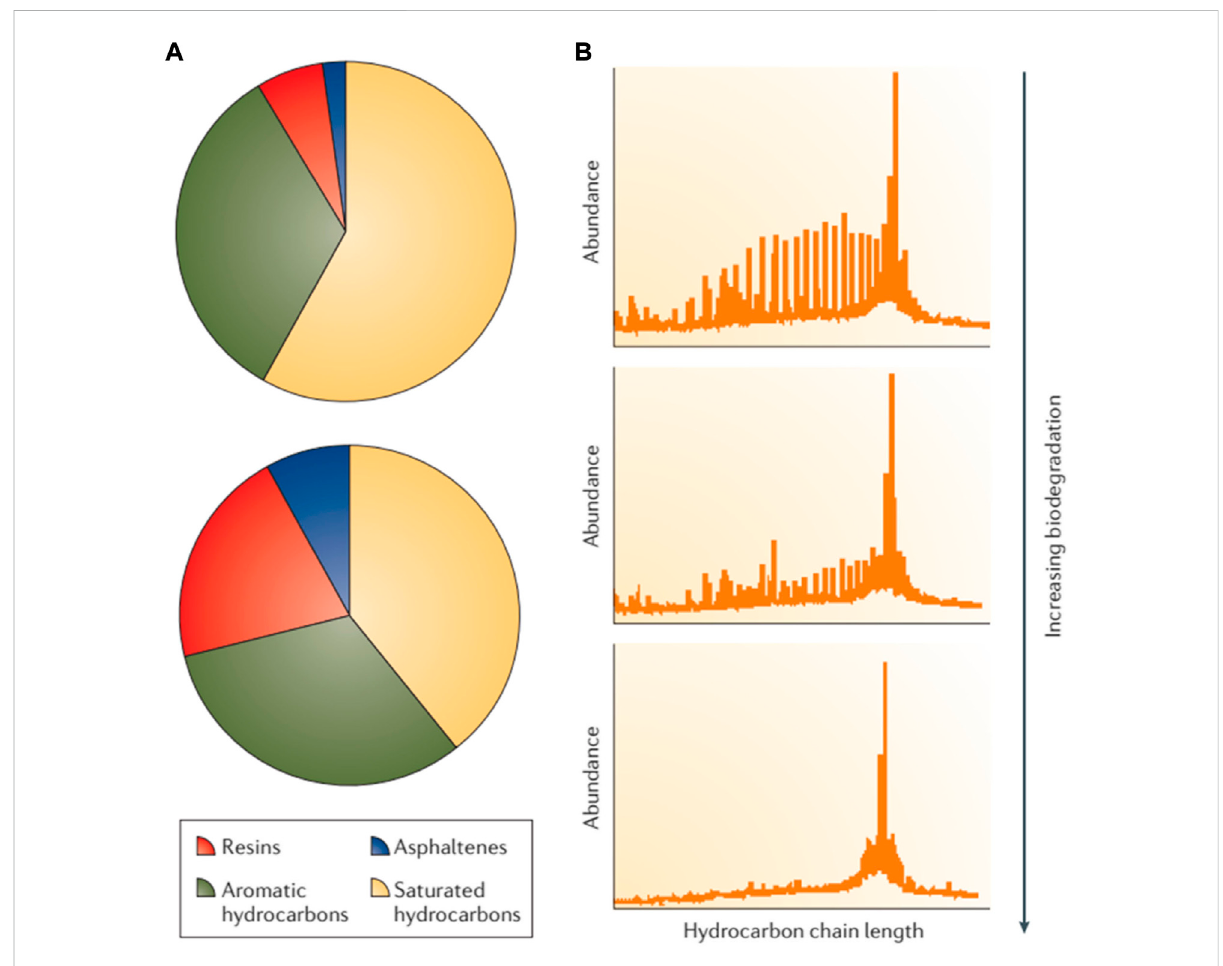
FIGURE 2 Effectofbiodegradationonoilcomposition. (A) Componentoflightcrudeoilandslightlybiodegradedheavycrudeoil,and (B) thecomponents of oil that is increasingly biodegraded (Head et al.,